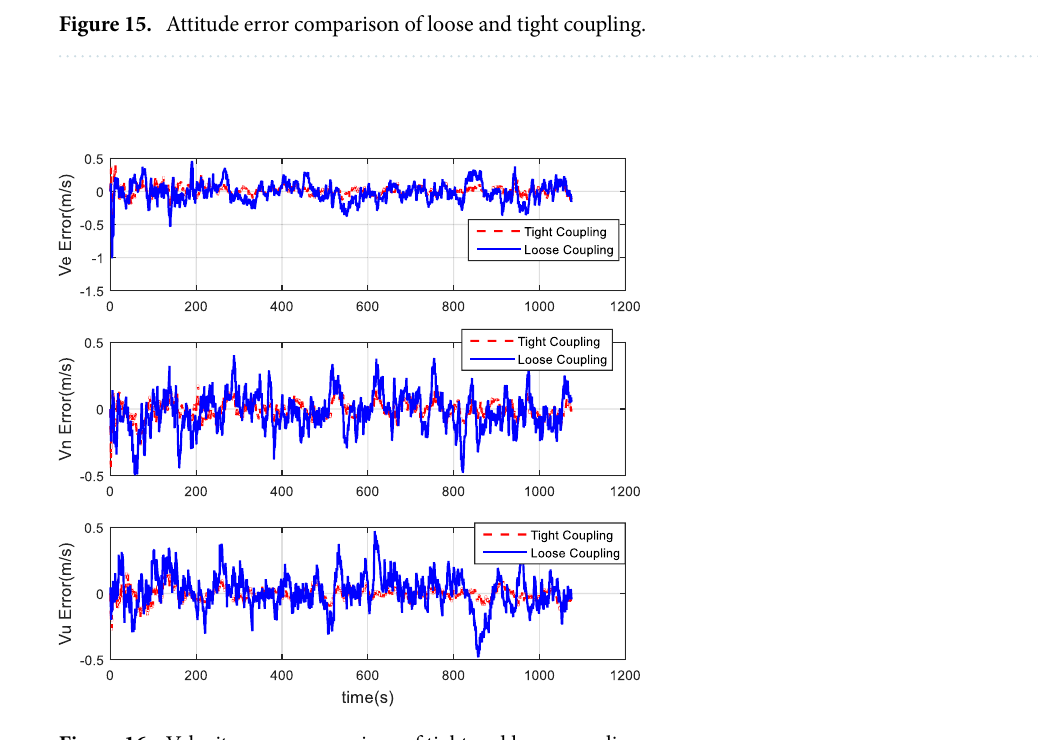
Figure 16. Velocity error comparison of tight and loose